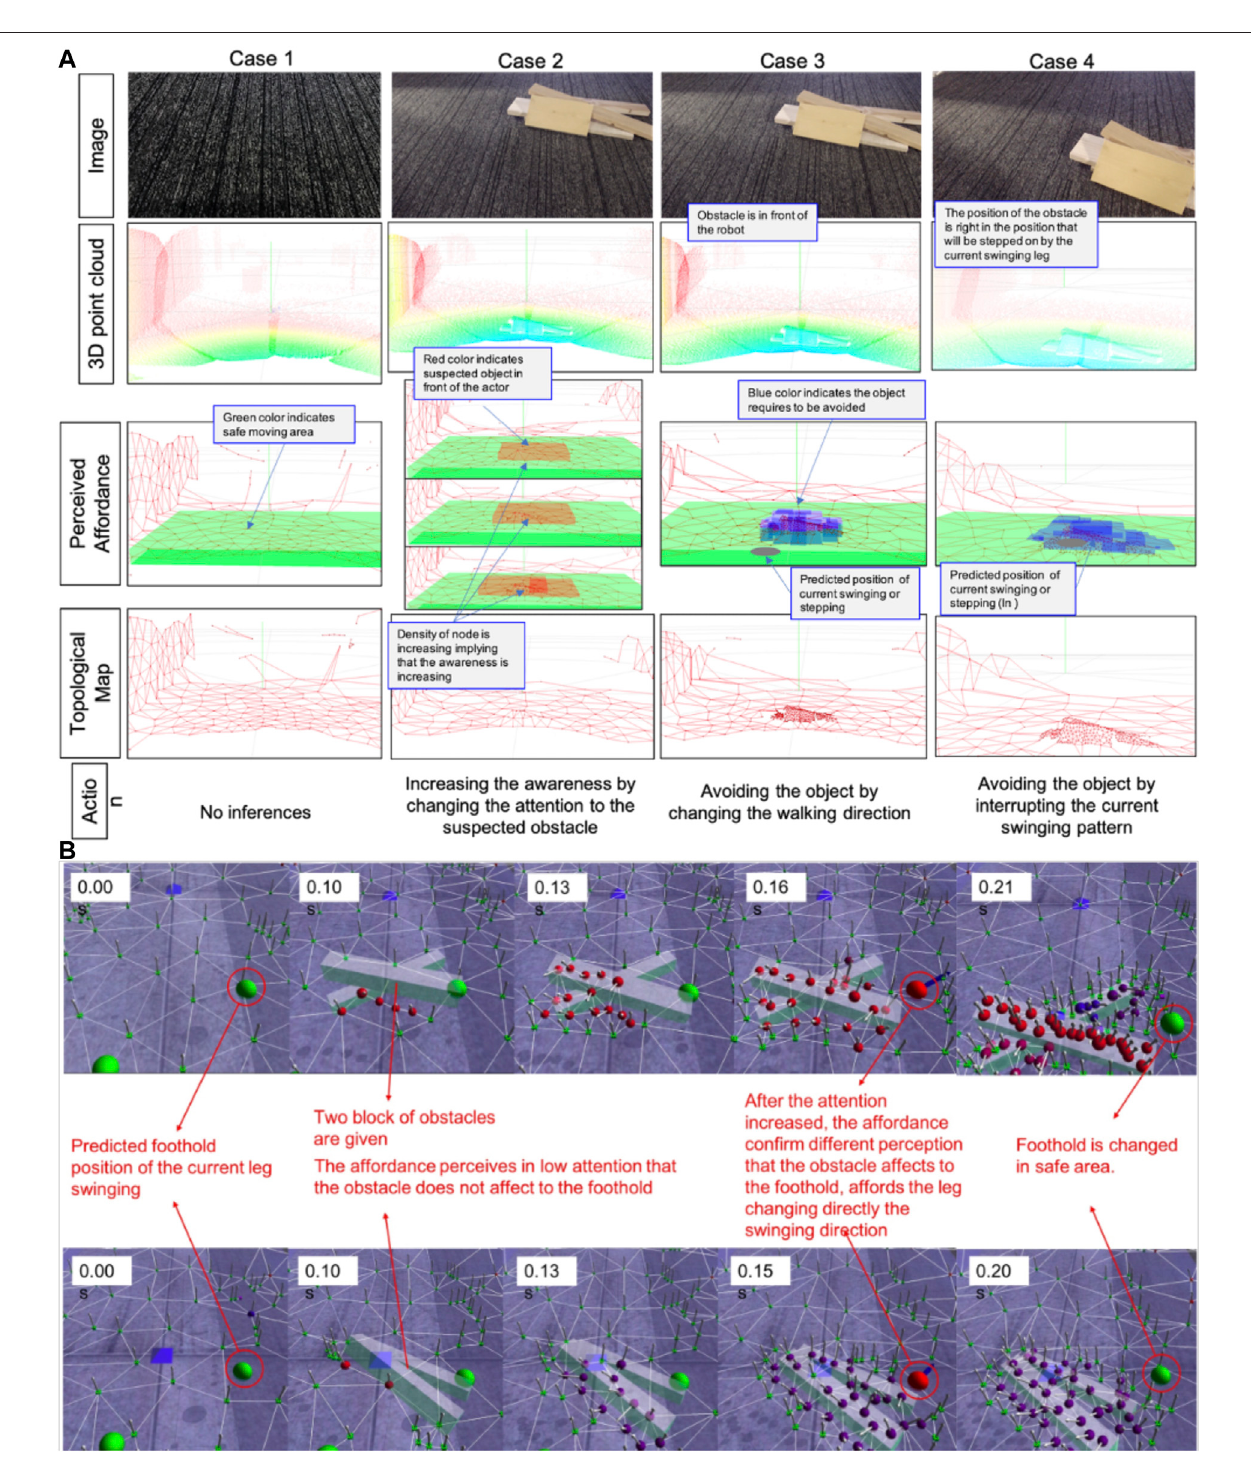
FIGURE 13 | (A) The result of different condition perception in different levels of data (3D point-cloud being the raw data from the depth sensors, topological map structure represent the attention model, perceived affordance, and generated action) (B) The snapshots show the integration between affordance and attention in computer simulation.